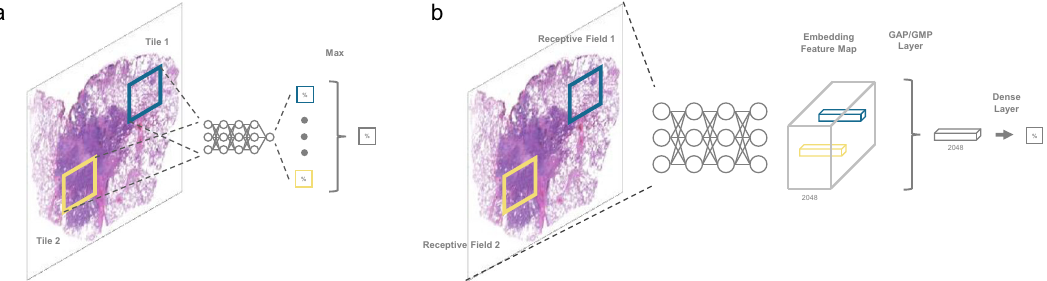
Fig. 8 Aggregation operations in MIL and in whole-slide training method. a In multiple-instance learning (MIL), a “ max ” operation is performed to select the most representative patches by their mapped predicted scores. b In the whole-slide training method, the front part of the model encodes the entire image into an embedding feature map, where each vector along the channel axis corresponds to a receptive fi eld. The following GMP (or GAP) layer embeds 2048 max (or average) operations to reduce the spatial dimension. Then, a dense layer performs a linear transformation followed by an activation function on the reduced 2048-length vector for a slide-level